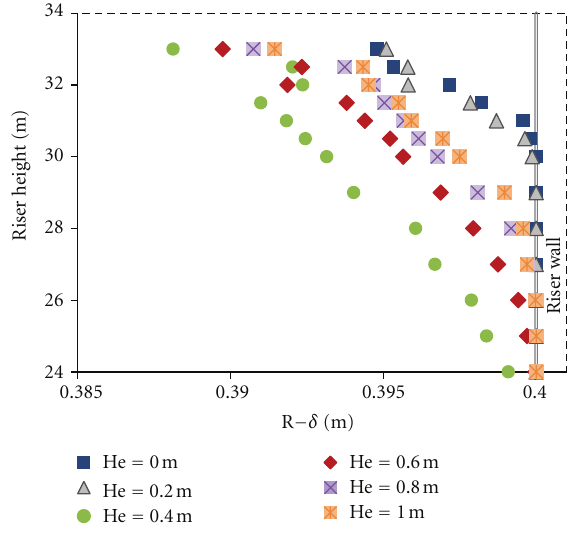
Figure 18: Film thickness of downflow.